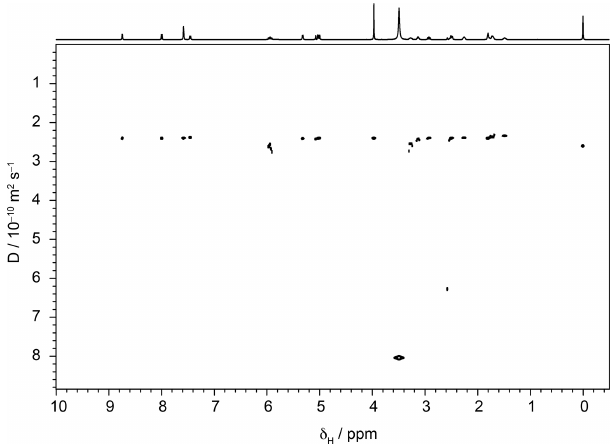
Figure 3. 500MHz Oneshot 1 H DOSY spectrum of 100mM qui- nine in DMSO-d 6 with 50mM sodium trimethylsilylpropionate as a reference, acquired as described in the text.